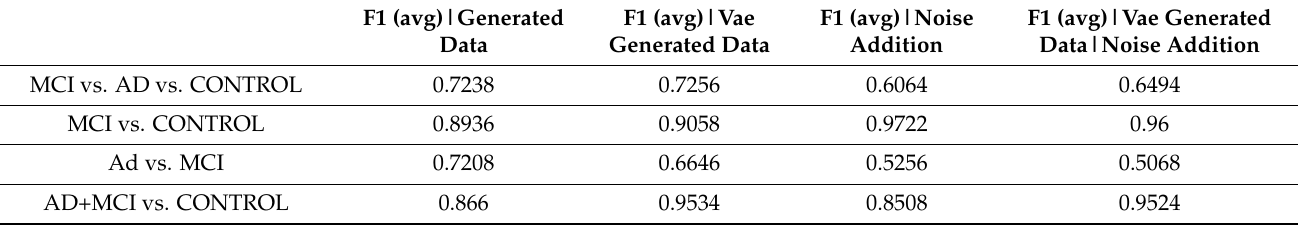
Table 2. Average accuracy and F1Score criteria for 50 trials for different time intervals. Results for 5 s (accuracy).